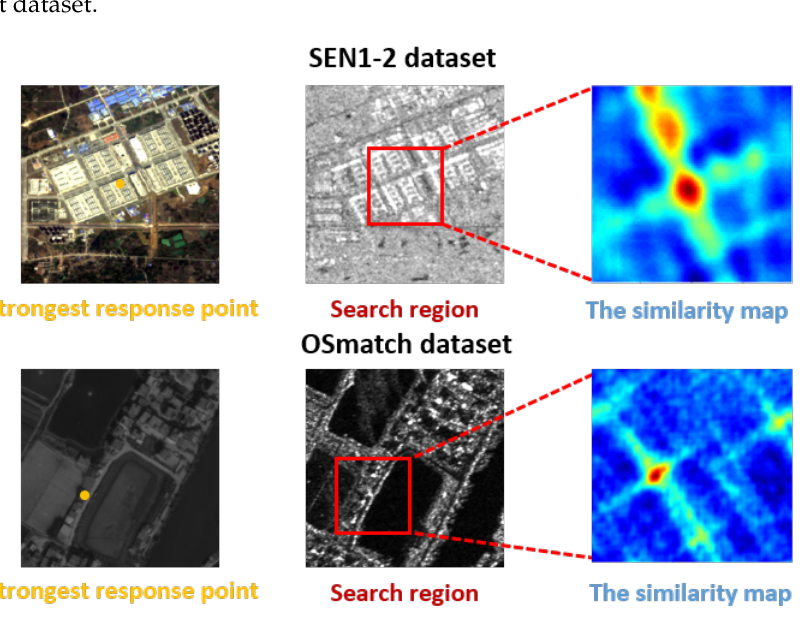
Figure 8. Samples of the test